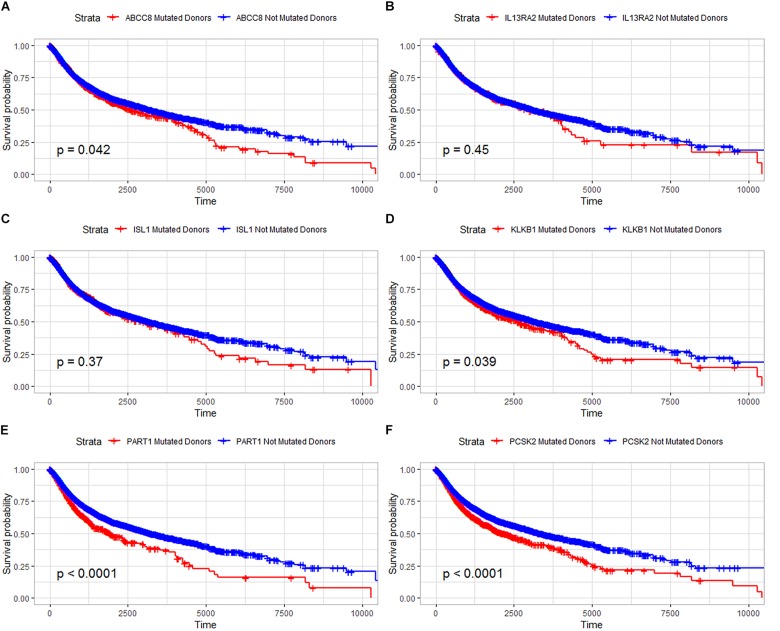
Overall survival analysis for six common DEGs in all diseases from the ICGC database. (A) Overall survival analysis for ABCC8, (B) overall survival analysis for IL13RA2, (C) overall survival analysis for ISL1, (D) overall survival analysis for KLKB1, (E) overall survival analysis for PART1, and (F) overall survival analysis for PCSK2.